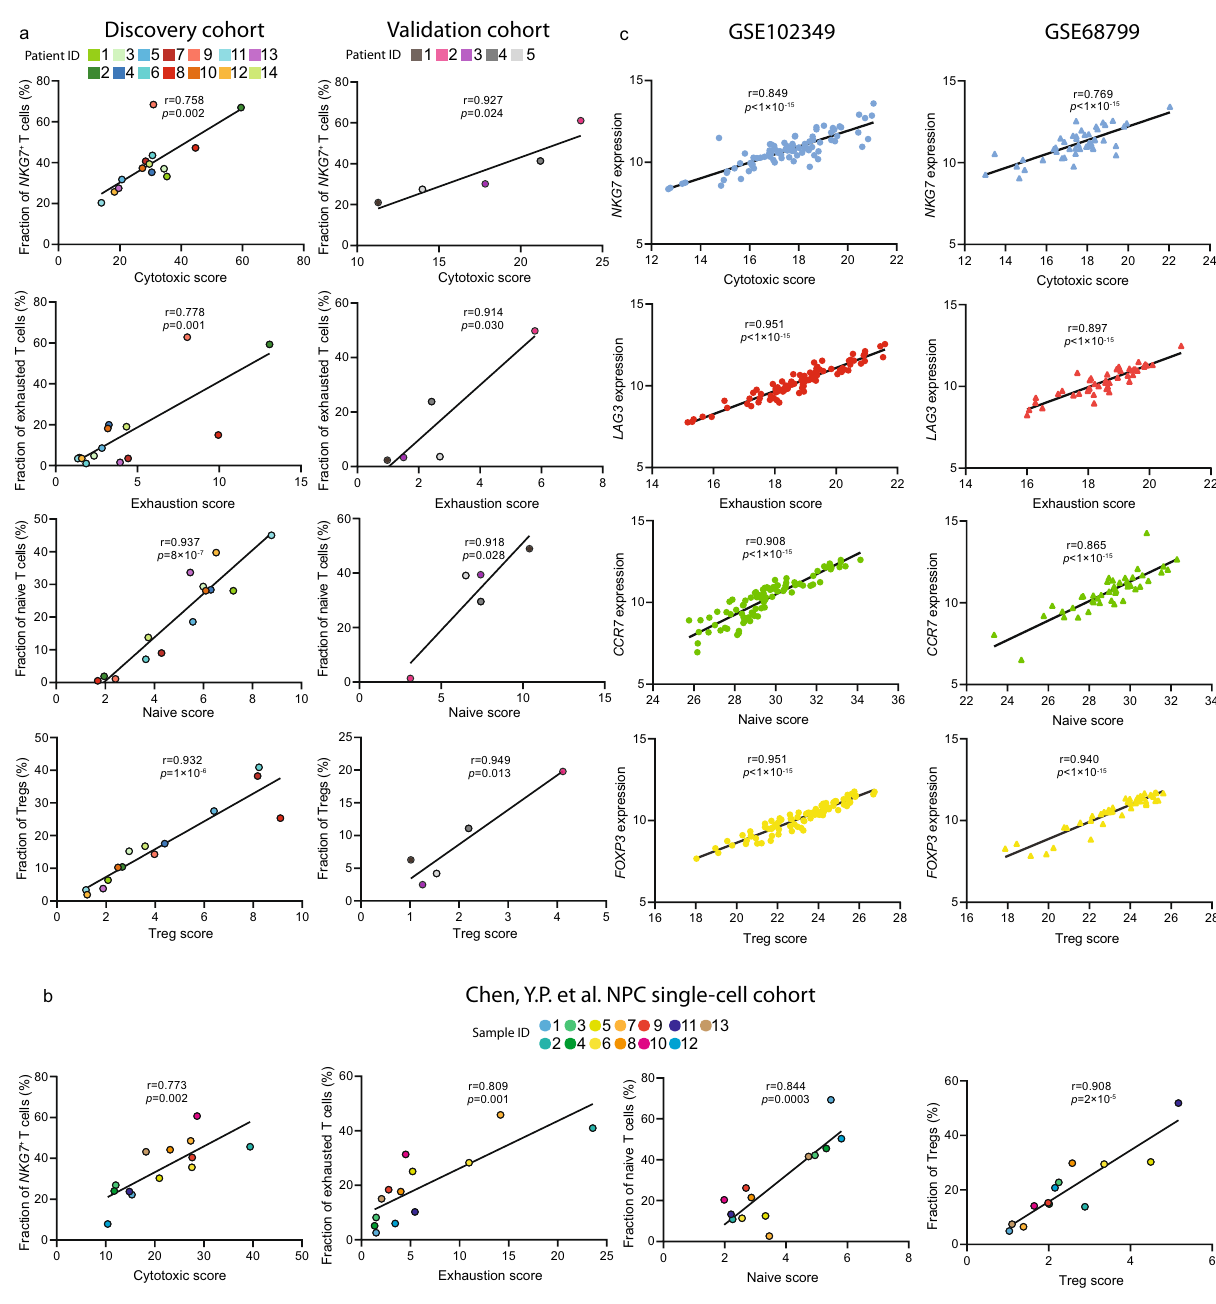
Fig. 4 Independent validation of the functional modules in bulk RNA sequencing and single-cell RNA sequencing cohorts. a The Pearson correlation analysis of functional scores (cytotoxic, exhaustion, naïve, and Treg) and the abundance of T cell subpopulations ( NKG7 + cytotoxic T cells, exhausted T cells, naïve T cells, and Tregs) in the discovery cohort and validation cohort. b The Pearson ’ s correlation analysis of functional scores (cytotoxic, exhaustion, naïve, and Treg) and the abundance of T cell subpopulations ( NKG7 + cytotoxic T cells, exhausted T cells, naïve T cells, and Tregs) in PY Chen, et al. NPC single-cell cohort. c The Pearson correlation analysis of functional scores and the corresponding genes in two GEO cohorts (GSE102349 and GSE68799), respectively. The two-sided p value for each functional module in GSE102349 and GSE68799 was extremely small (<1 × 10 − 15 ), therefore the exact p values cannot be shown in the fi gure. Source data are provided as a Source Data fi